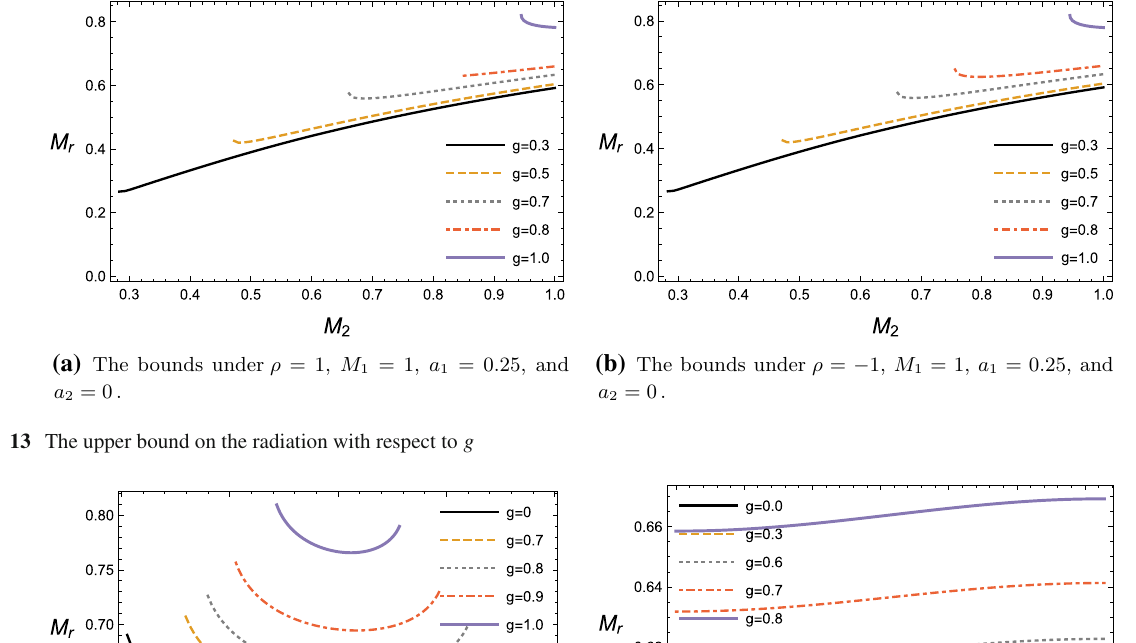
the radiation is more sensitive to the parameter g (Fig. 13) than the parameter ρ (Fig.